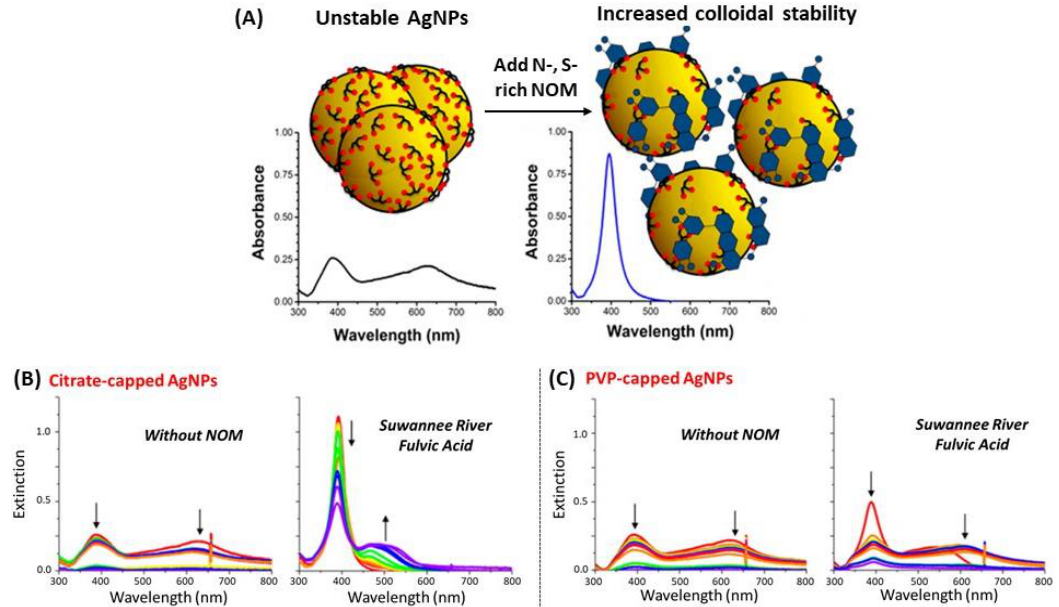
Figure 9. ( A ) Illustration of natural organic matter (NOM) interactions with the surface of silver nanoparticles according to the NOM’s chemical composition and the affinity of the capping agent for the AgNP surface. Colloidal stability of ( B ) citrate- and ( C ) PVP-capped AgNPs in the absence or the presence of NOM from various origins. Adapted from [117]. Copyright (2015), American Chemical Society.